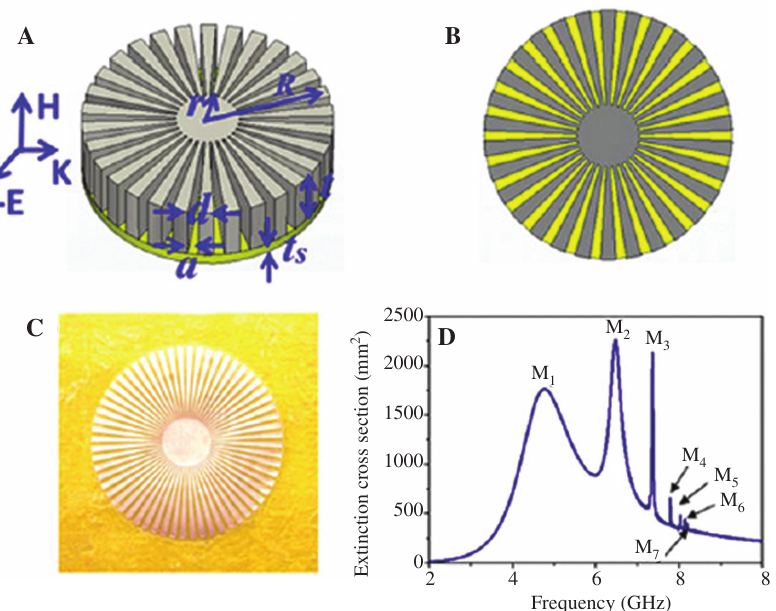
Figure 21: The textured metallic disk and the resonance properties. (A) A 3D structure with the inner and outer radii r and R , which is based . The thickness of the metallic disk ( t ) can be varied from infinity to nearly zero. on a thin dielectric substrate (yellow part) with thickness t s (B) A planar textured structure. (C) The photograph of a fabricated planar textured metallic disk ( t = 0.018 mm) on a flexible dielectric sub- = 0.4 mm, in which R = 10.0 mm, r = 0.25 R , a = 0.4 d , and N = 60. (D) The simulated ECS spectra of the thin planar struc- strate with thickness t s